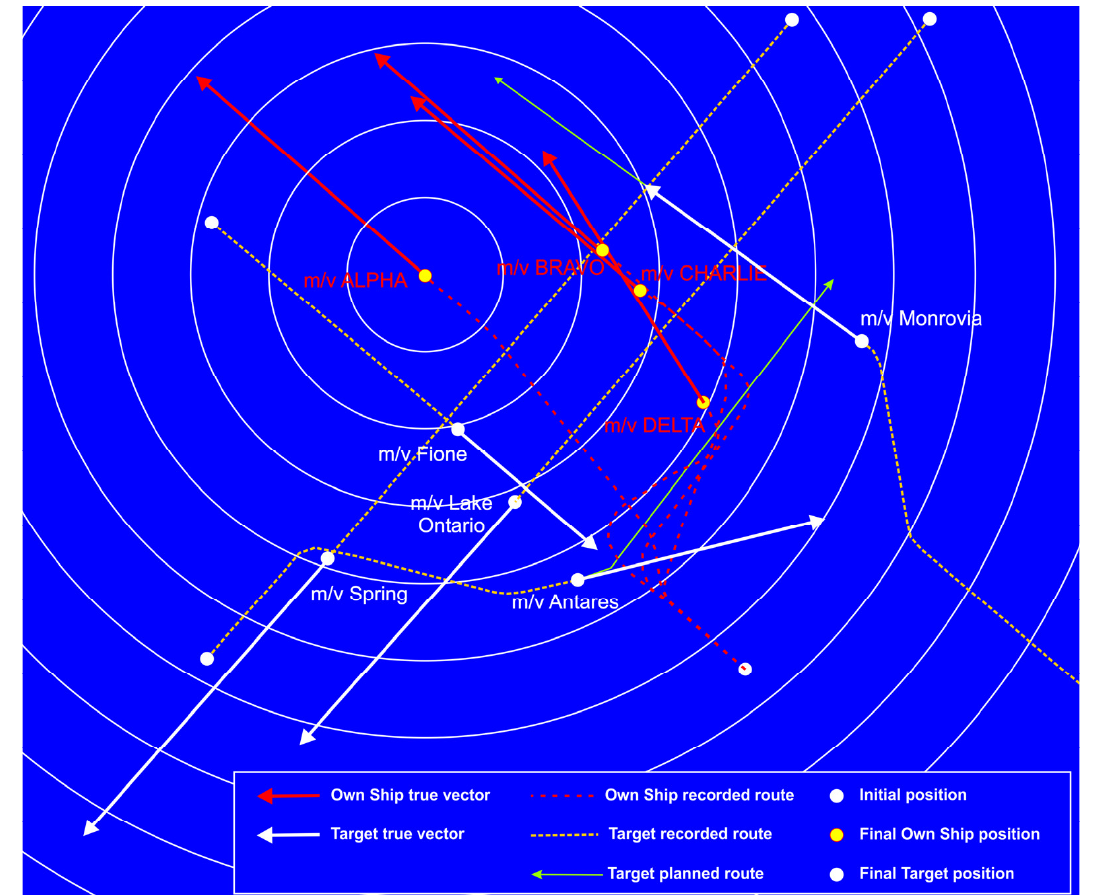
Figure 9. Navigation situation after 26 min of simulation-scenario reviewed by experts. Table 2. Results of the traditional evaluation conducted by experts and compared to the automatic evaluation of the SEA program. Colors indicate the most important data in the table for